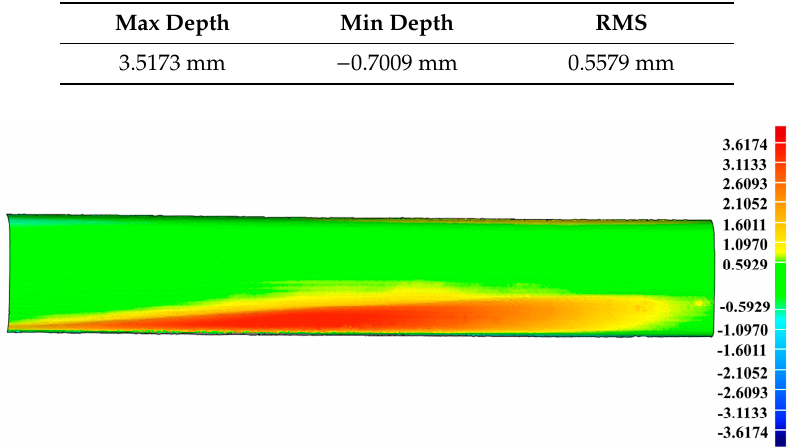
Figure 21. The depth-difference between the reference PCM and the scratch-surface PCM on the practical damaged rail.